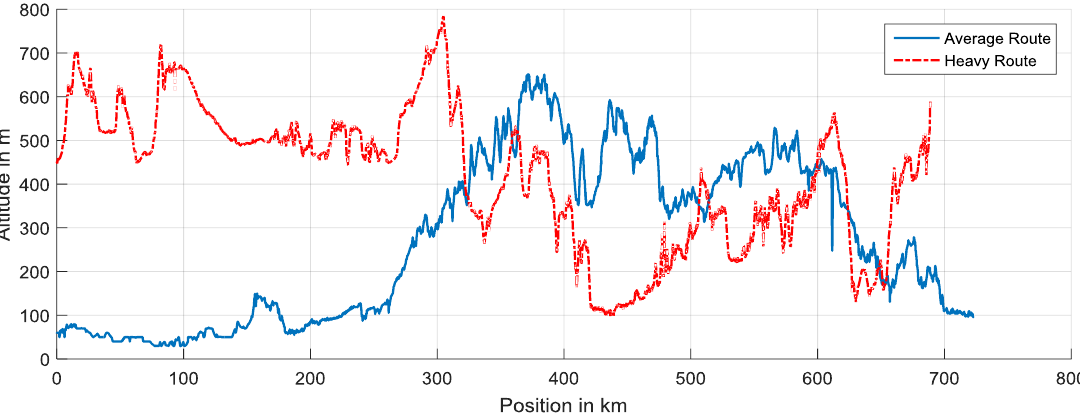
Figure 8. Altitude profiles of the routes for the transportation scenarios.